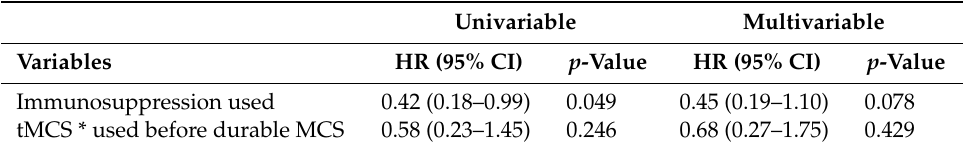
Figure 3. Survival probability of patients with giant cell myocarditis by left ventricular support (LVAD) alone or biventricular (BiVAD) support.